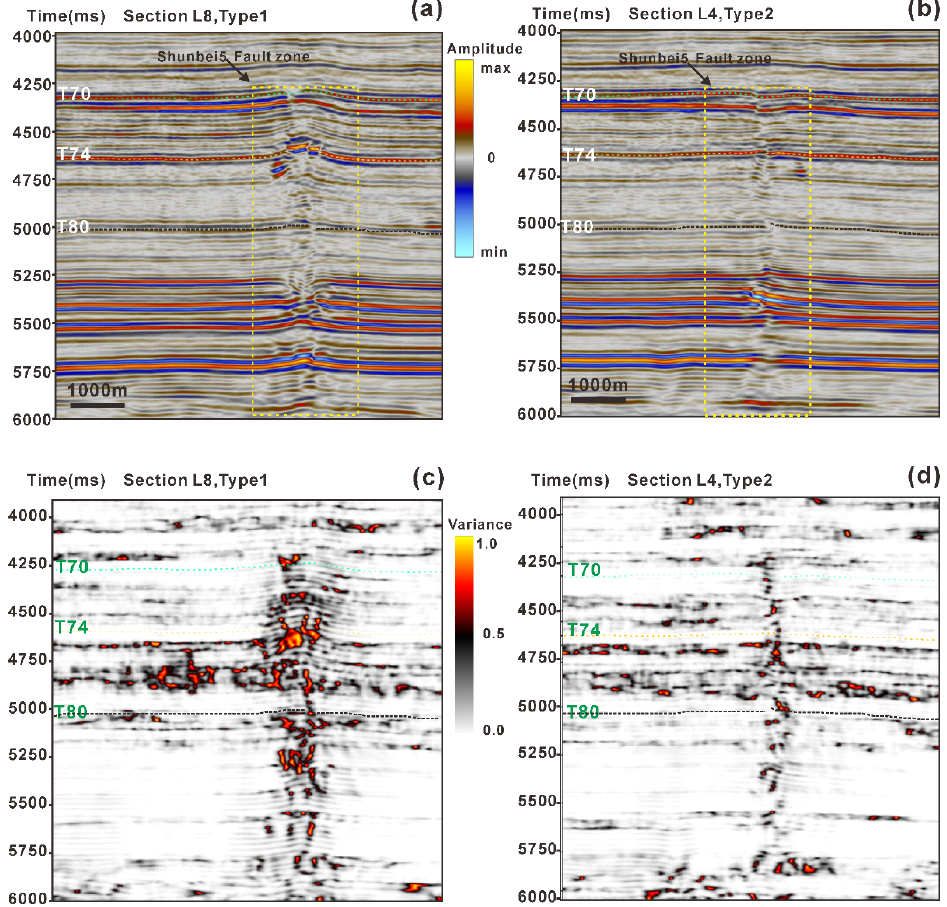
Figure 6. ( a , b ) are original seismic profiles of L8, L4, respectively, ( c , d ) are seismic variance profiles of L8, L4, respectively. (Type 1: compressive uplifting segments, type 2: strike-slip segments).